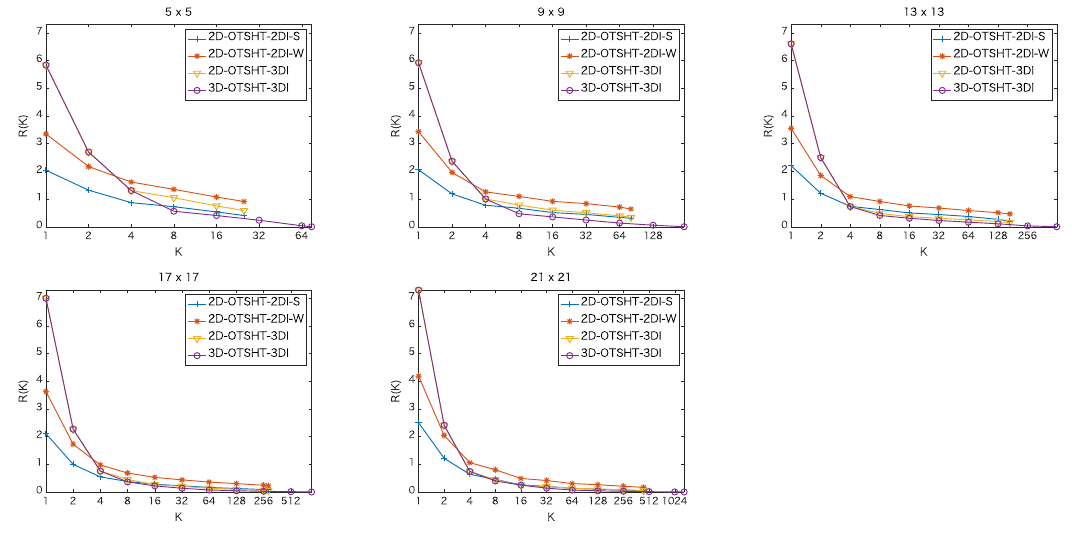
Figure 4. Percentage of extra patches remaining at K basis images/blocks in color images of size 256 256. ×